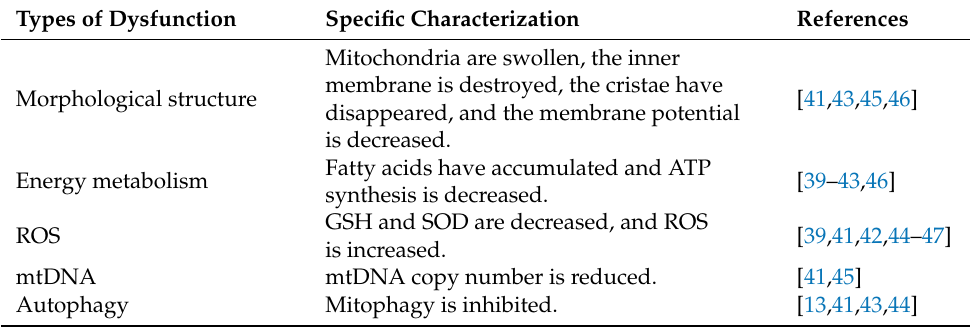
Table 3. Characterizations of mitochondrial dysfunction in